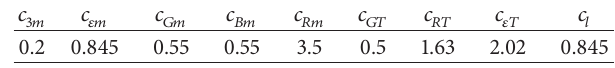
Table 1: Coefficients of the SGS